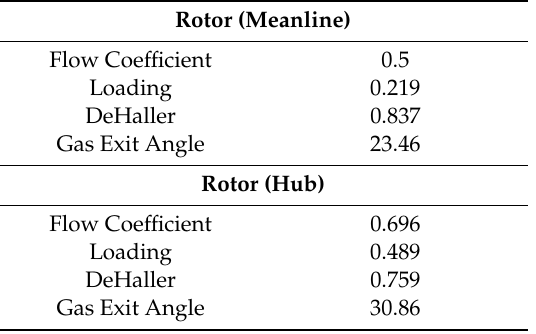
Table 9. Results from the 1D meanline analysis for the design point 4, iteration